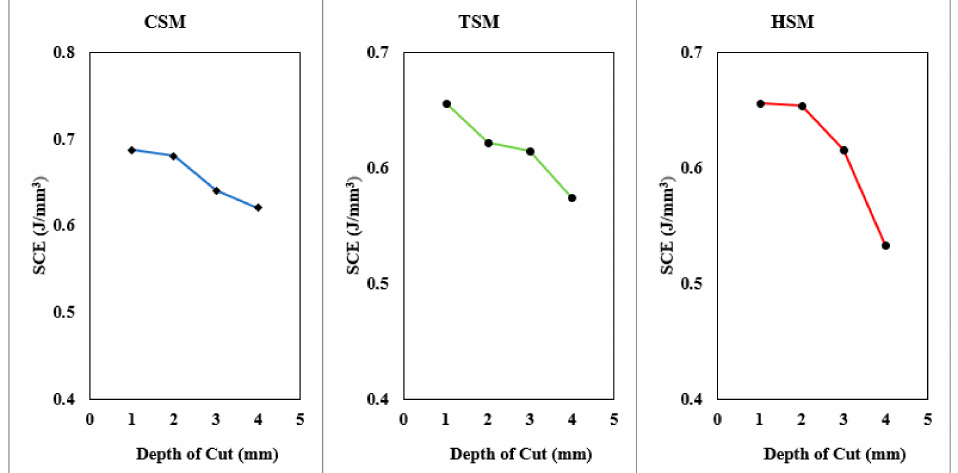
Figure 14. Effect of depth of cut on SCE in three machining